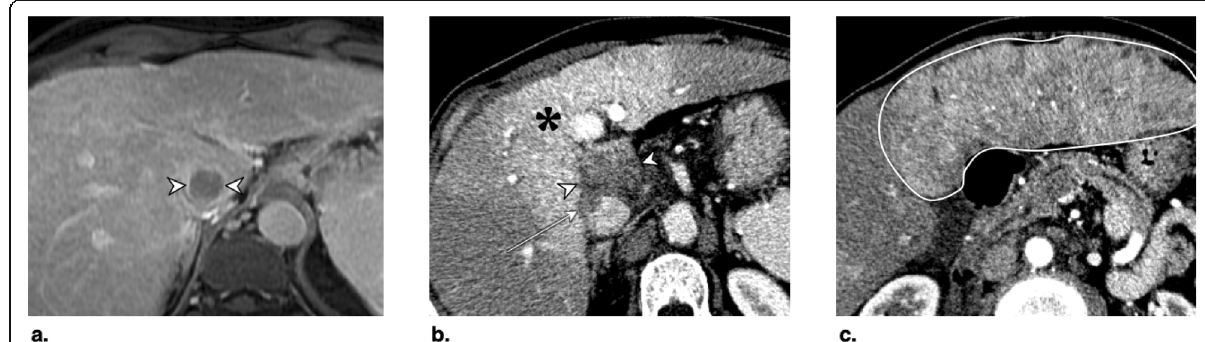
Fig. 31 a Axial T1-weighted MR in portal venous phase obtained pretreatment: image shows washout of a 2.5 cm LR-5 observation in caudate lobe (arrow). b Axial CT in late arterial phase (AP) obtained 3 months post stereotactic body radiotherapy (SBRT): image shows tumor progression (arrowheads) and perfusional anomalies related to edema (asterisk). Mural thrombus in inferior vena cava is noted (arrow). The treated